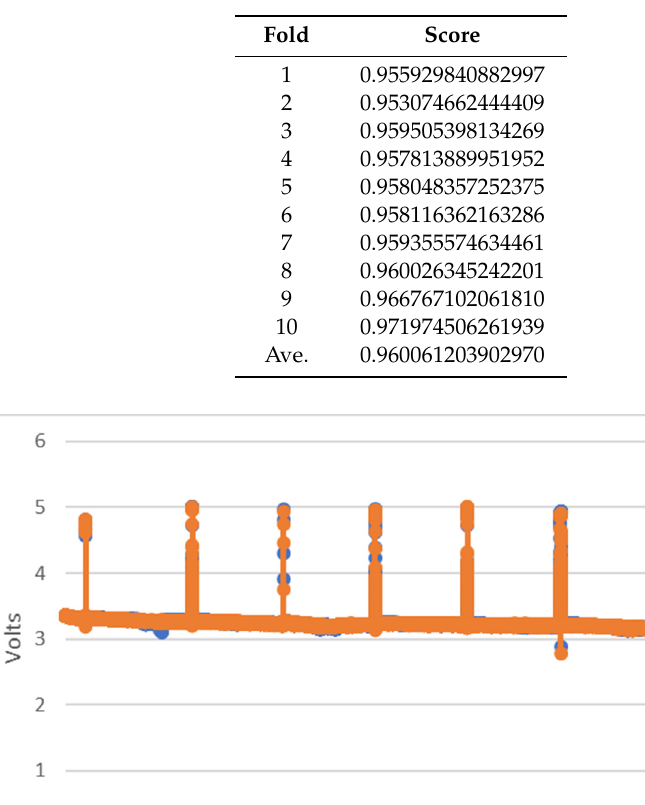
Table 4. Regression score function of each fold.